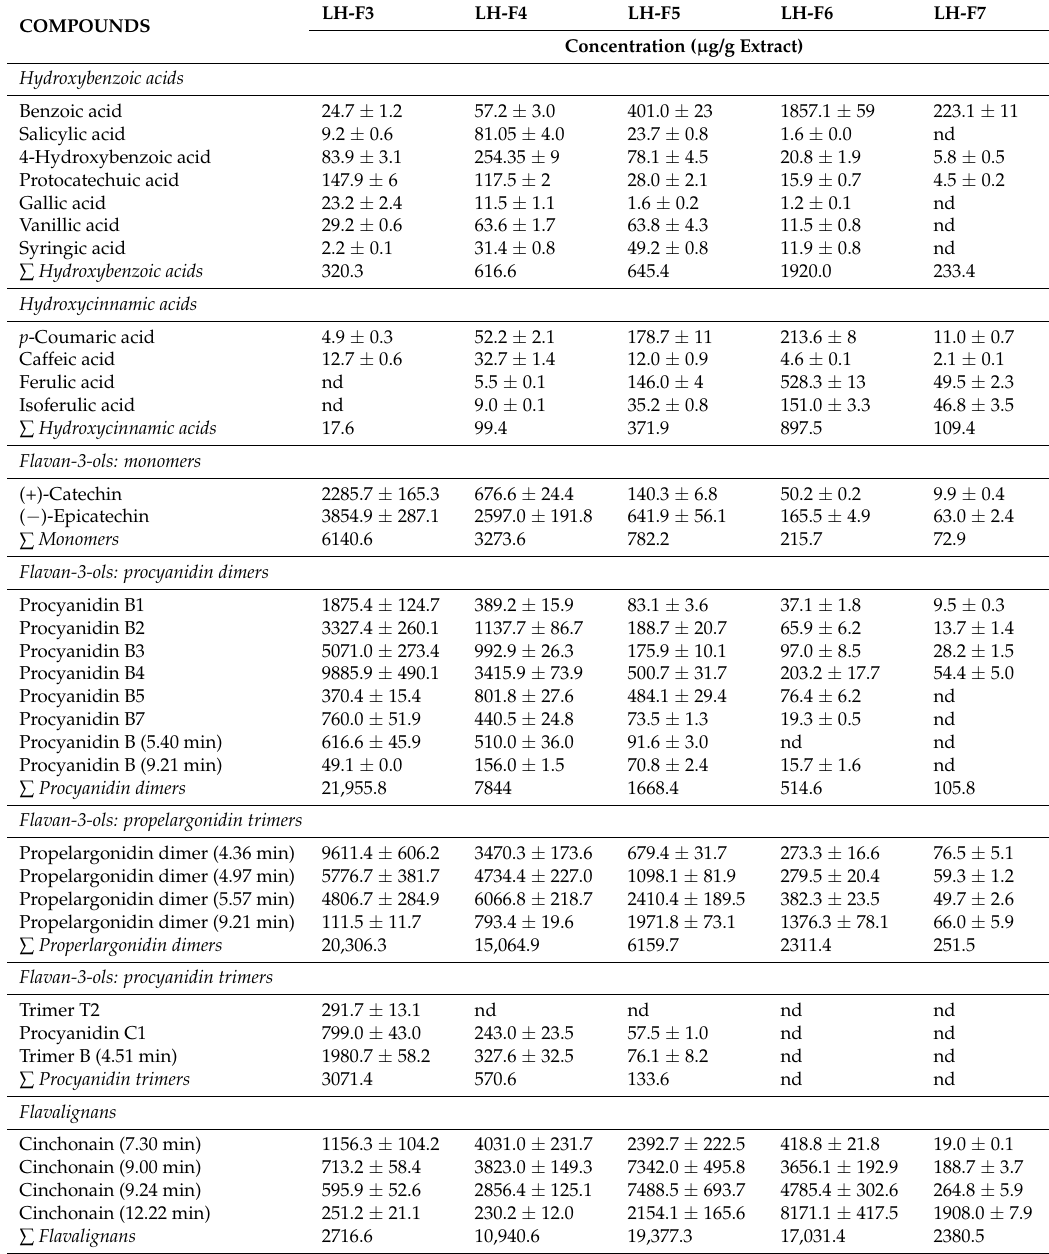
Table 1. Phenolic composition of leaves fractions of U.